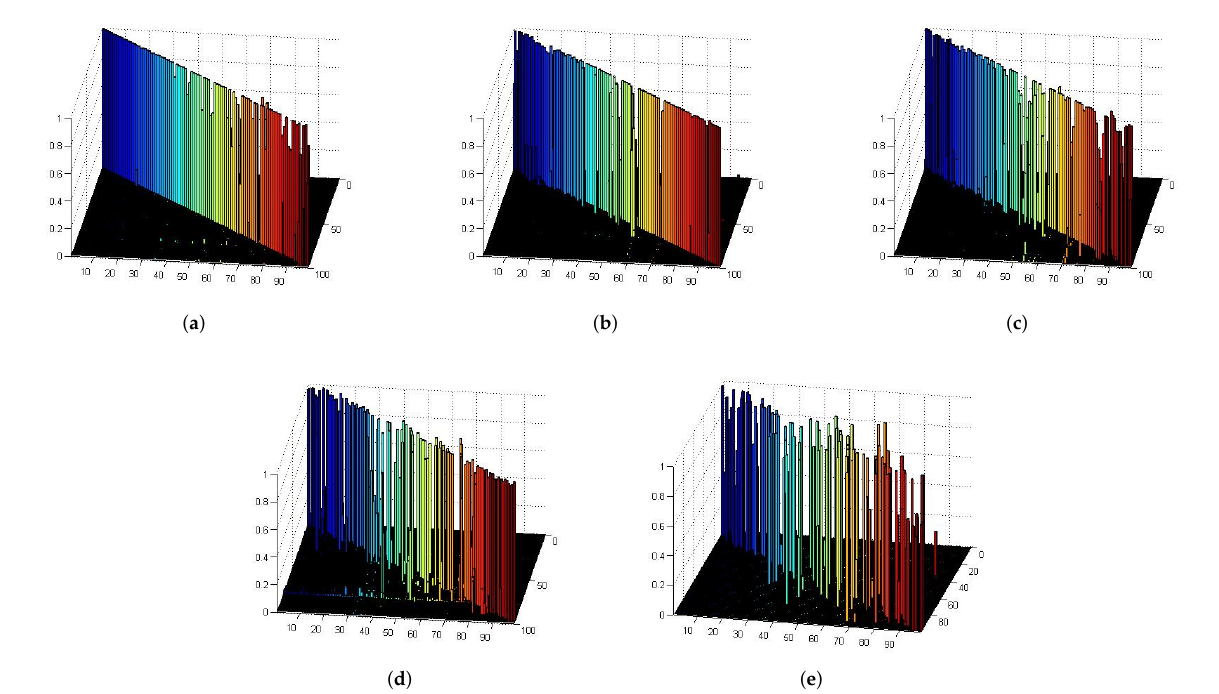
Figure 5. The assignment matrix obtained by MLGM from matching results on the Fish dataset with different degree of deformation ( a – e ).